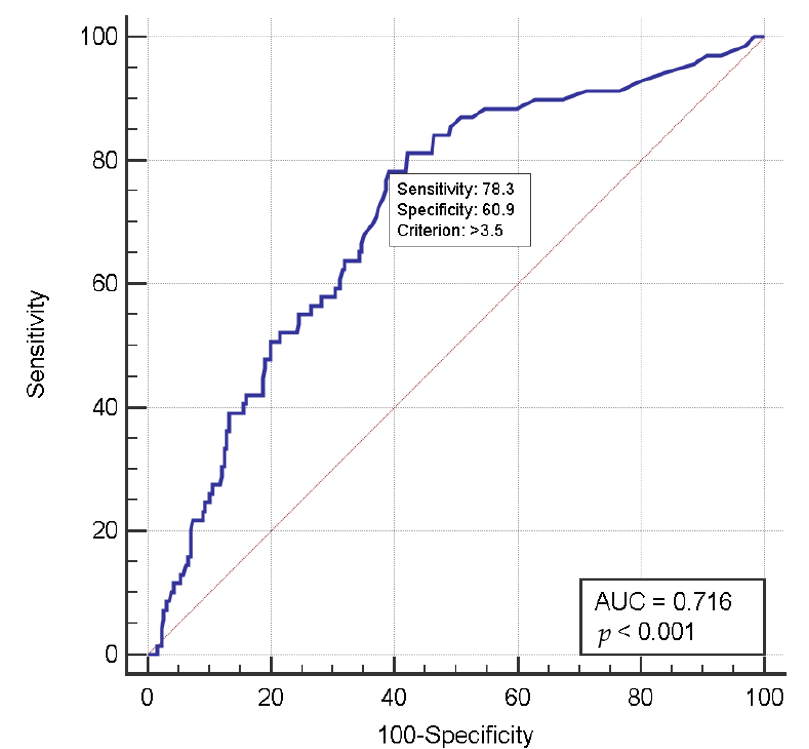
Figure 2. Diagnostic performance (receiver operating characteristic curve) of serum bilirubin level for predicting the incidence of postoperative delirium in liver transplant patients.